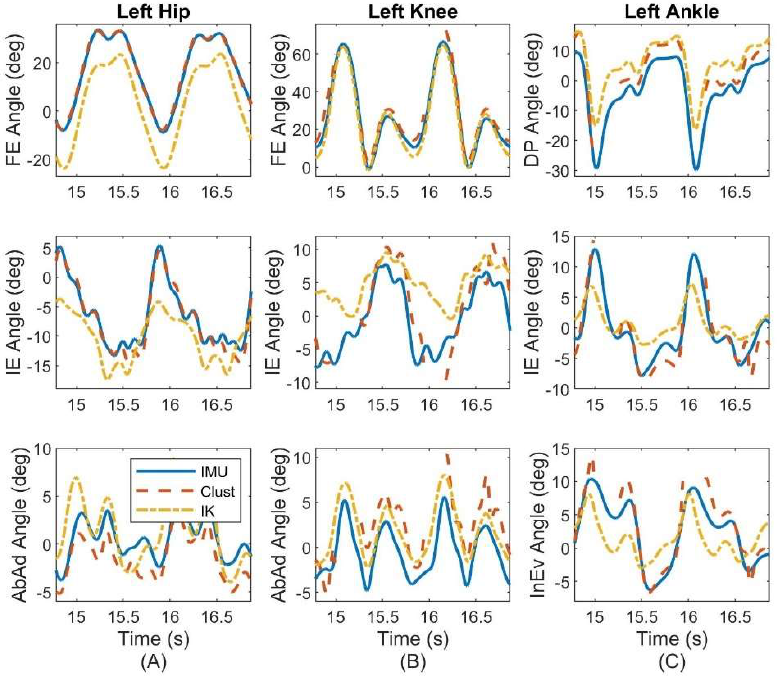
Figure A2. Fast Walking. Example joint angle estimates over two stride cycles for fast treadmill walk- ing. Plots show the three anatomical angles for ( A ) left hip, ( B ) left knee, and ( C ) left ankle. Estimates are also compared between ErKF (IMU), cluster (Clust), and inverse kinematics (IK) methods.